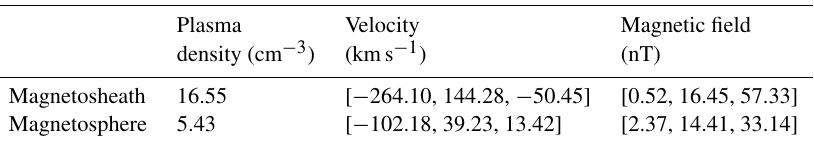
Figure 1. Overview of KH waves observed by MMS on 27 September 2016. From the top, panels show (a) the magnetic field, (b) the electric field, (c) the plasma density, (d, e) the ion temperature and velocity, (f, g) the electron temperature and velocity, (h) the total pressure (sum of the thermal and magnetic pressures) and (i, j) the ion and electron omnidirectional energy flux. Table 1. The magnetic field and plasma parameters at the magnetosphere and magnetosheath side during the wave interval, which are averaged from the dashed and dotted boxes in Fig.